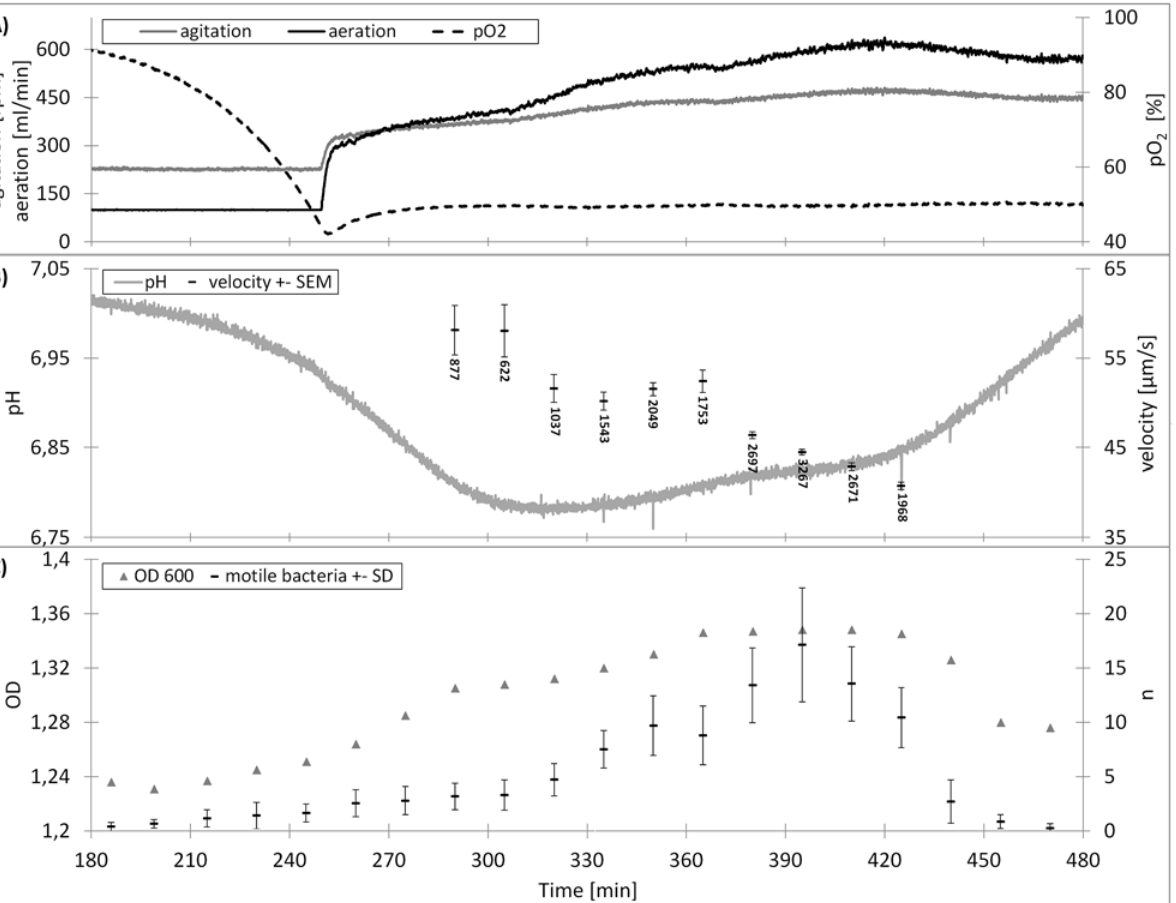
Fig 6. Cultivation of Bacillus amyloliquefaciens FZB42. A) Monitored aeritation and agitation data. B) pH and mean bacteria velocity, below the bars are the numbers n of determined velocity vectors per sample. C) optical density (OD 600) and mean number of motile bacteria observed in the field of view of the flow cell, corrected by dilution factor of the